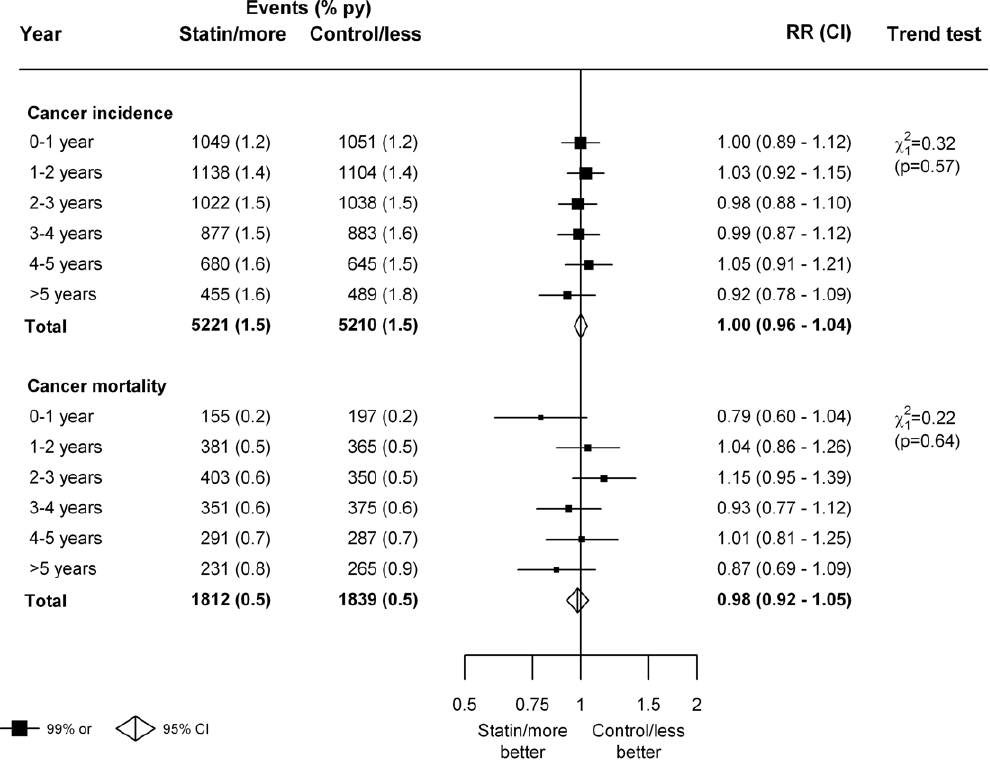
Figure 3. Effects of statin therapy on cancer incidence and mortality, by duration of treatment. Symbols and conventions as in Figure 1.